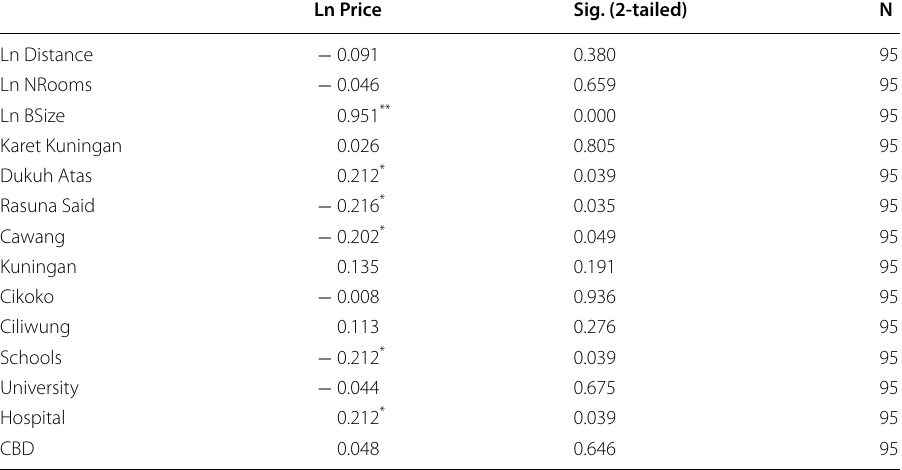
* Correlation is significant at the 0.05 level (2-tailed) ** Correlation is significant at the 0.01 level